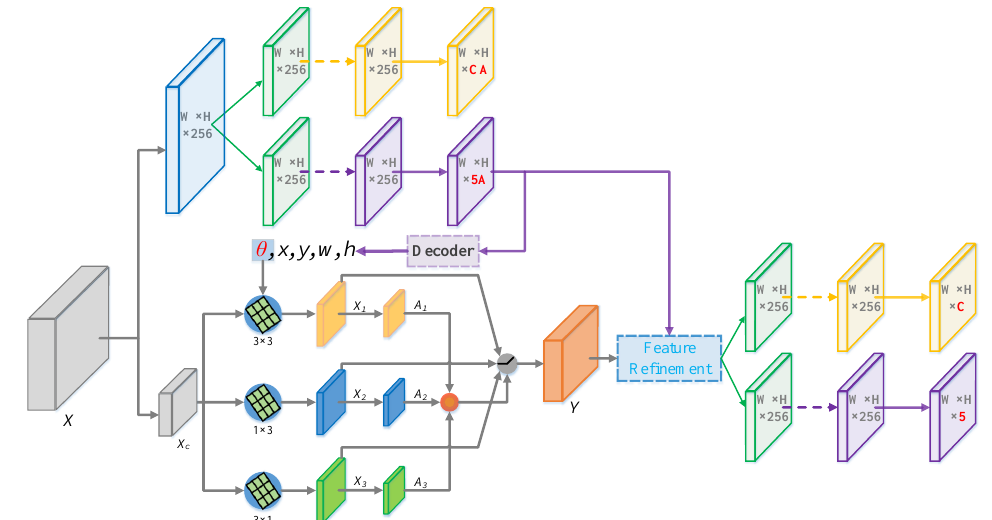
Figure 6. Architecture of the post-processing step. This consists of two sub-steps: the first sub-step and the refinement sub-step. Top: the first sub-step, which performs the preliminary regression of angle anchors for the refinement sub-step. Bottom: the refinement sub-step, which performs feature fusion and adaptive feature refinement and then gives the final object detection result precisely. On the left of the refinement sub-step is the feature fusion module, followed by the feature refinement module. On the right are two subnetworks, which perform object classification and